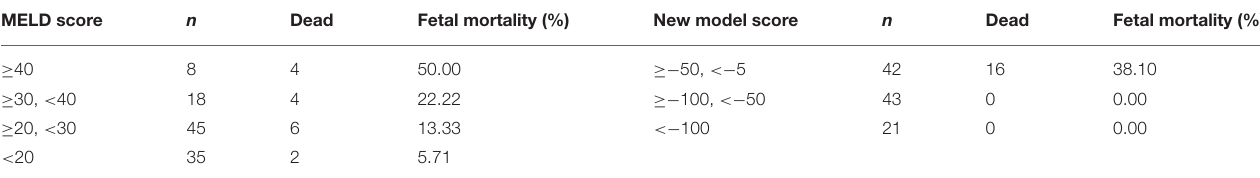
TABLE 12 | Relationship between MELD score and the new model for fetal mortality. MELD score n Dead Fetal mortality (%) New model